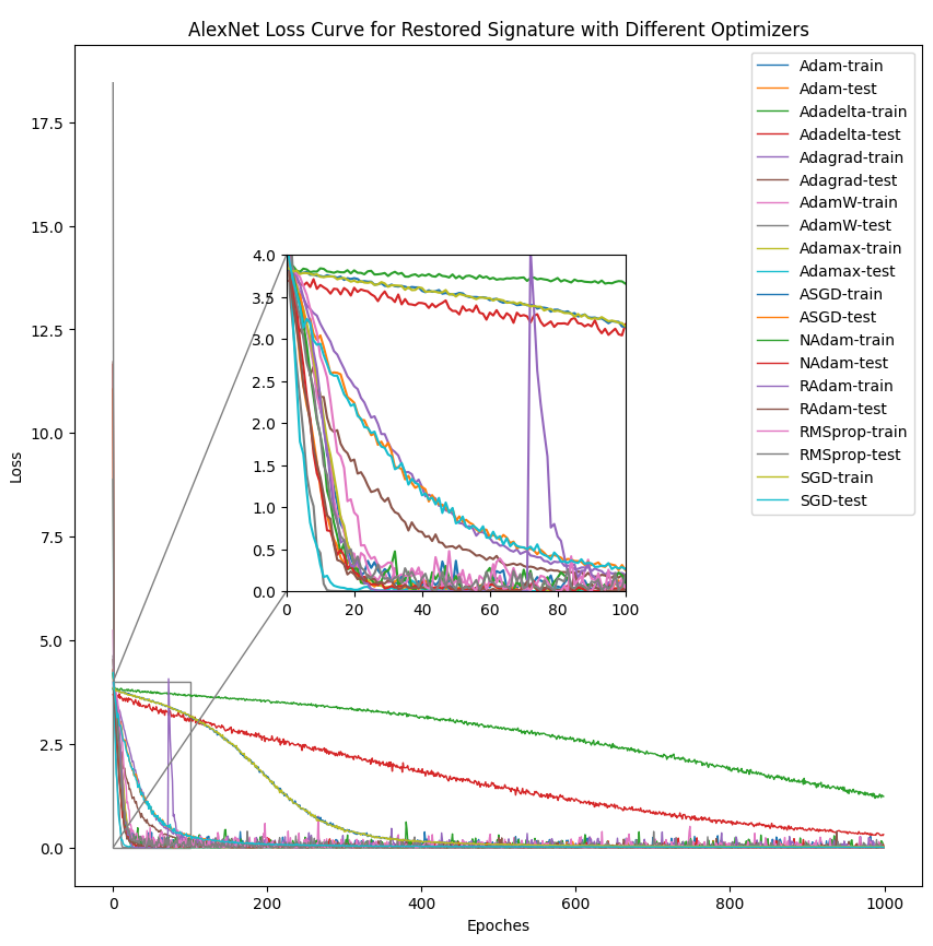
Figure 12. The loss curve of AlexNet with respect to 10 different optimizers. Both the learning loss and testing loss for each optimizer are covered in the graph. The zoom-in area is ( x 1 , x 2 ) = (0, 100), ( y 1 , y 2 ) = (0,